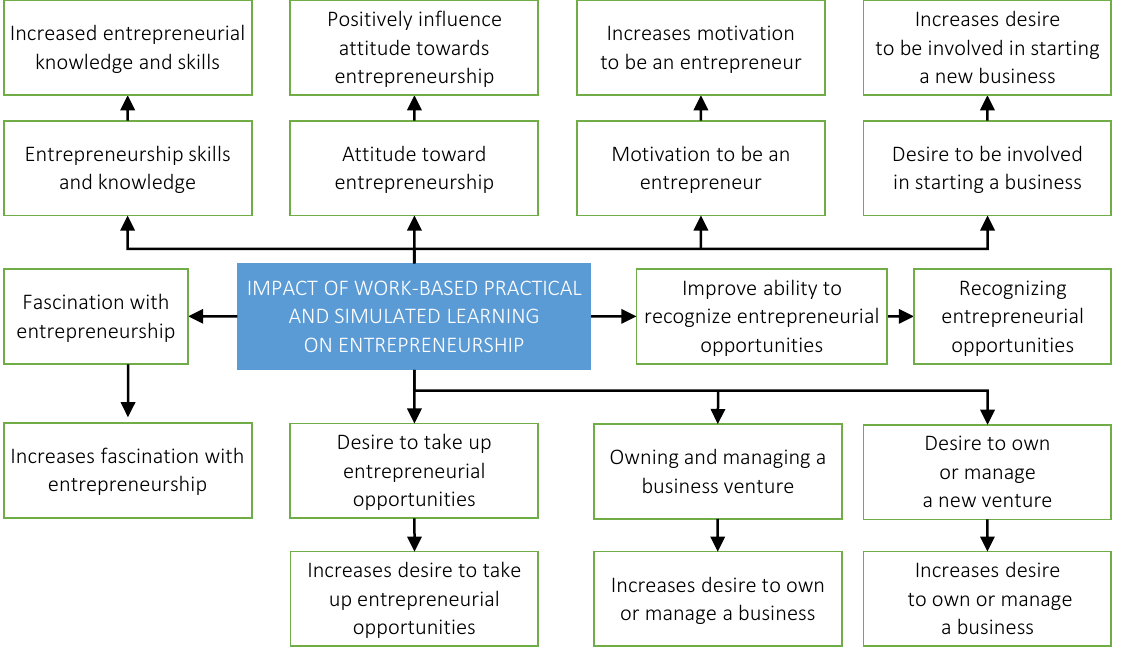
Figure 1. WBL impact on entrepreneurial behaviors and development of an entrepreneurship